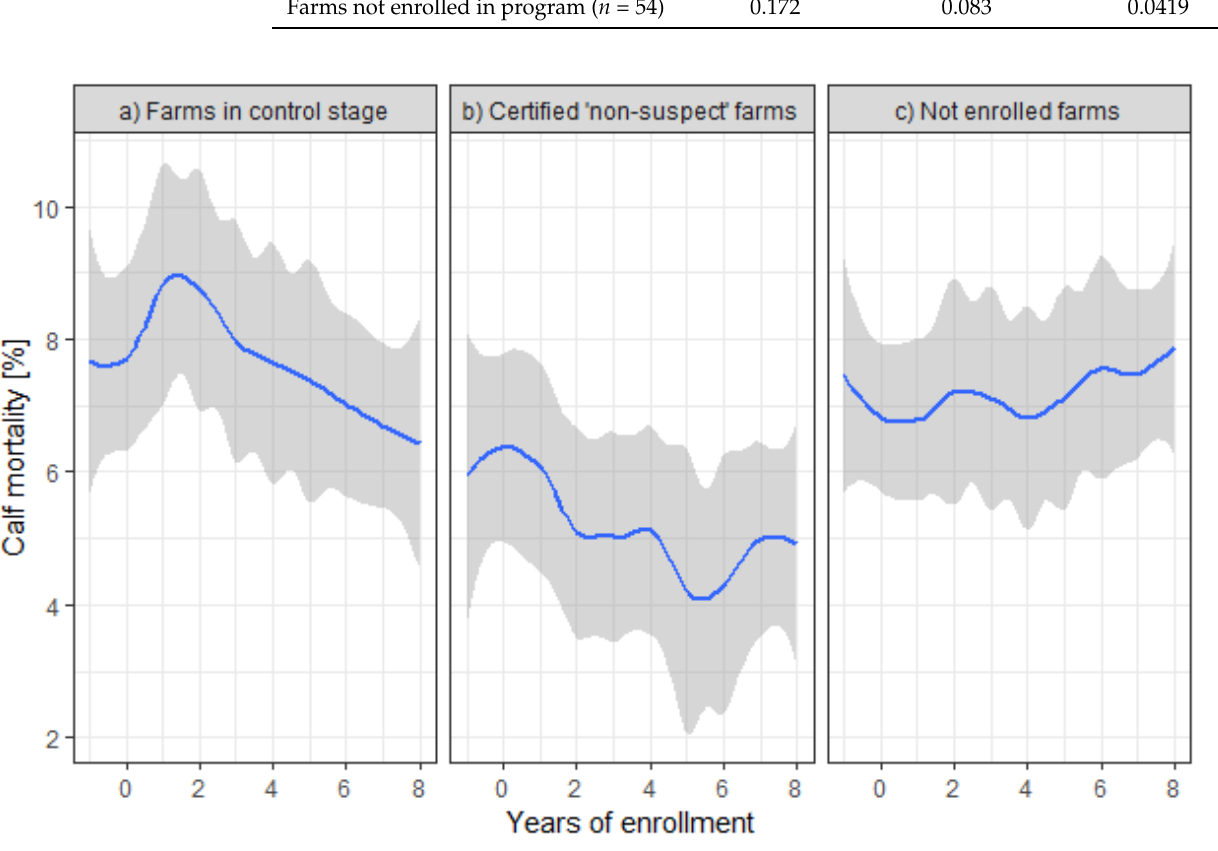
Figure 3. Mean (blue line) and 95% confidence interval (grey) of calf mortality during 10 consecutive years from the year before enrollment to 8 years after enrollment in Thuringian Johne’s Disease Control Program for dairy farms in the control stage ( a ), dairy farms certified as ‘non-suspect’ regarding JD during this period of time ( b ), and for dairy farms not being enrolled (observational period 2008–2017 ( c